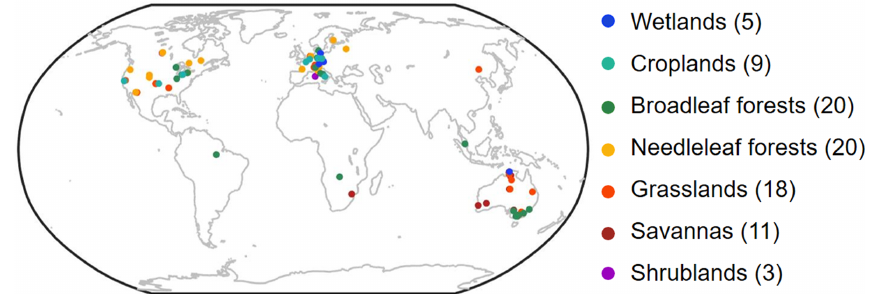
Figure 1. Location of the 86 flux sites used in this study. Numbers in the brackets indicate the number of sites for each biome